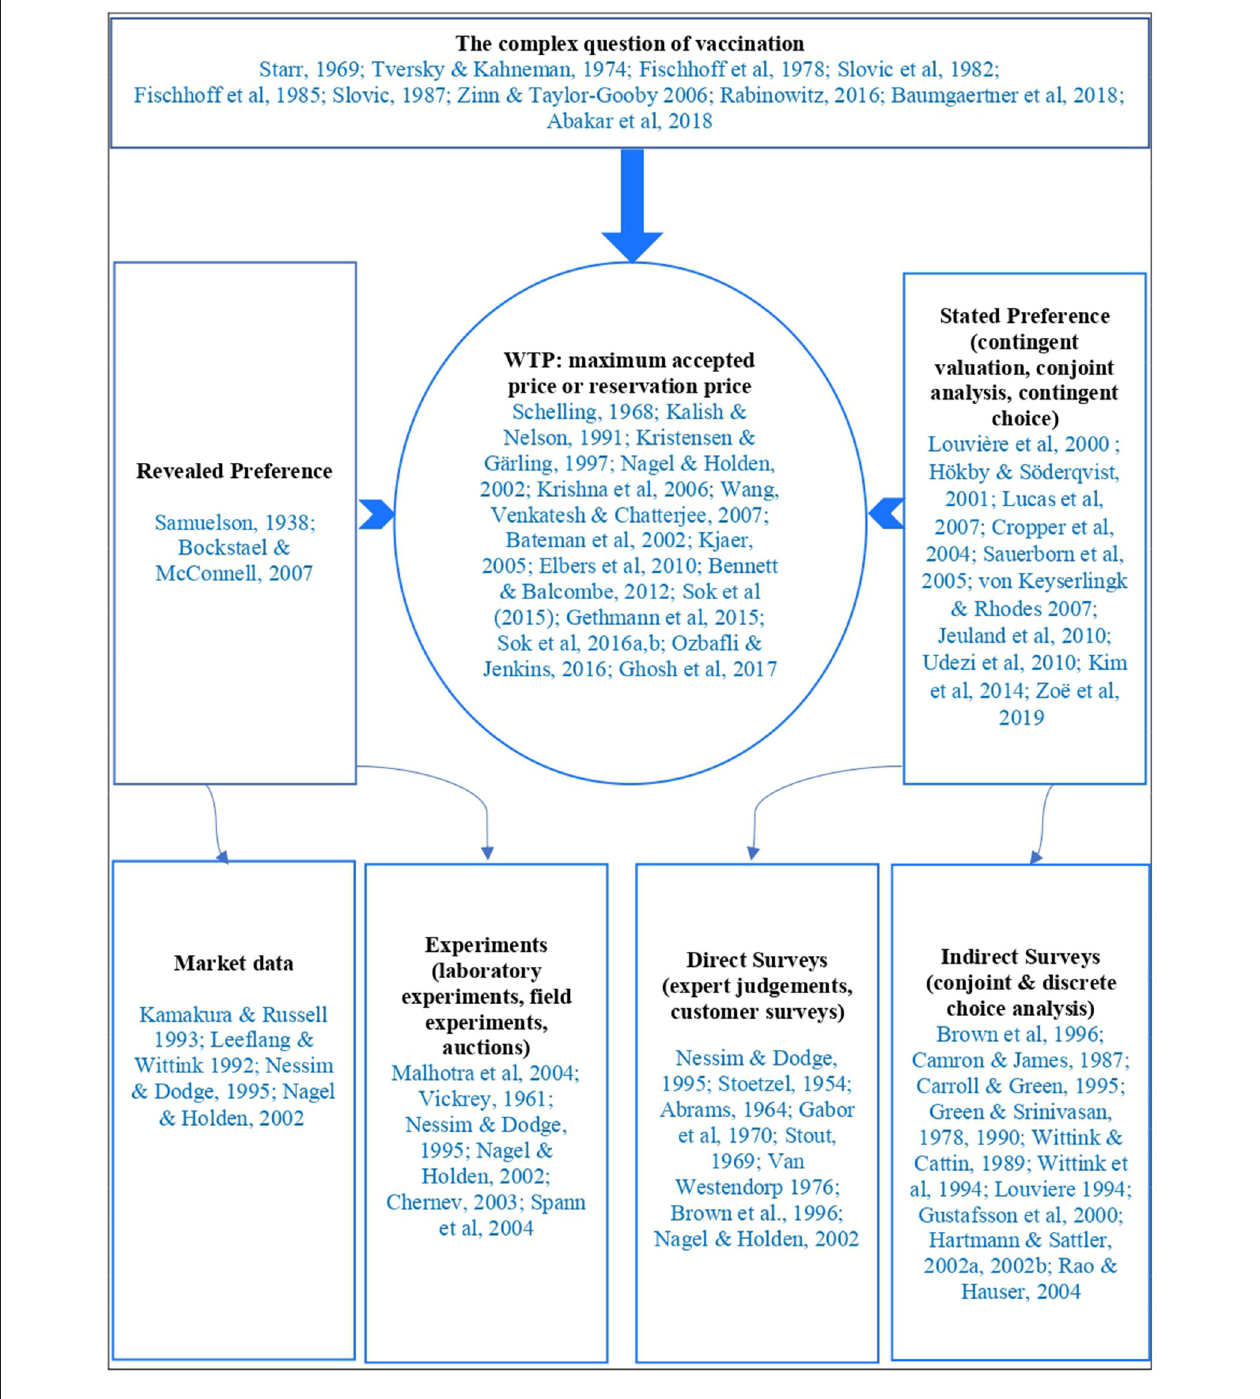
FIGURE 1 | Vaccination behaviors and measurement methods of consumer’s willingness to pay.